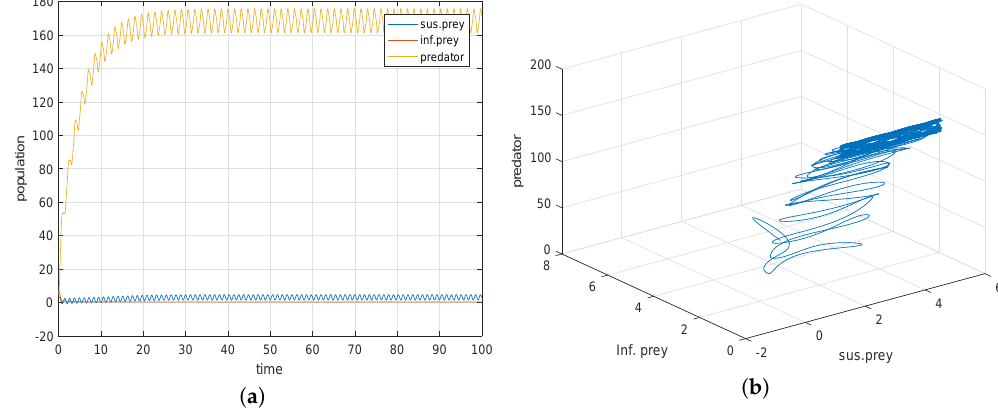
Figure 7(a) represents the variations of populations against time with the parameters α = 10 ,α 2 = 20 ,α 3 = 30 . Figure 7(b) represents the variation of species against the time with the parameters α = 10 ,α 2 = 20 ,α 3 = 30 . Figure 7. ( a ) the oscillations of populations against time with high intensities (high noise) of parameters α 1 = 10, α 2 = 20, α 3 = 30; ( b ) the phase-portrait diagram of populations under random high noise of parameters α 1 = 10, α 2 = 20, α 3 =